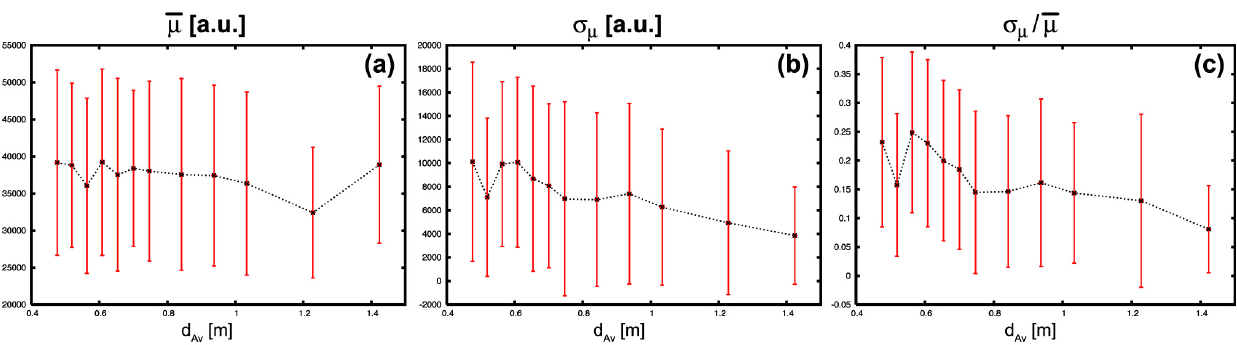
Figure 23 . Comparison of (a) average trial response, (b) standard deviation during a trial, and (c) standard deviation divided by the average trial response, all measured against the average distance to the gas source d Av . Each figure shows the average of the respective indicator over the trials with a particular distance from the gas source. The respective standard deviation is indicated by error